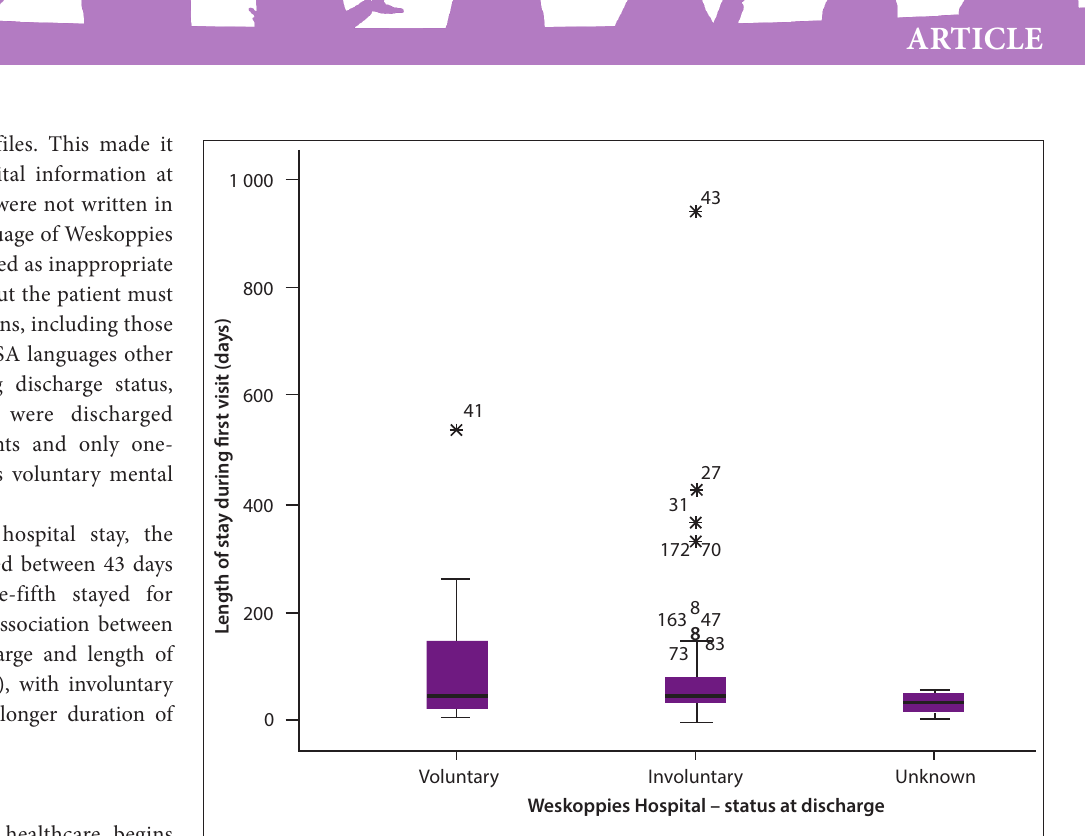
Fig. 3. Association between length of stay and status at